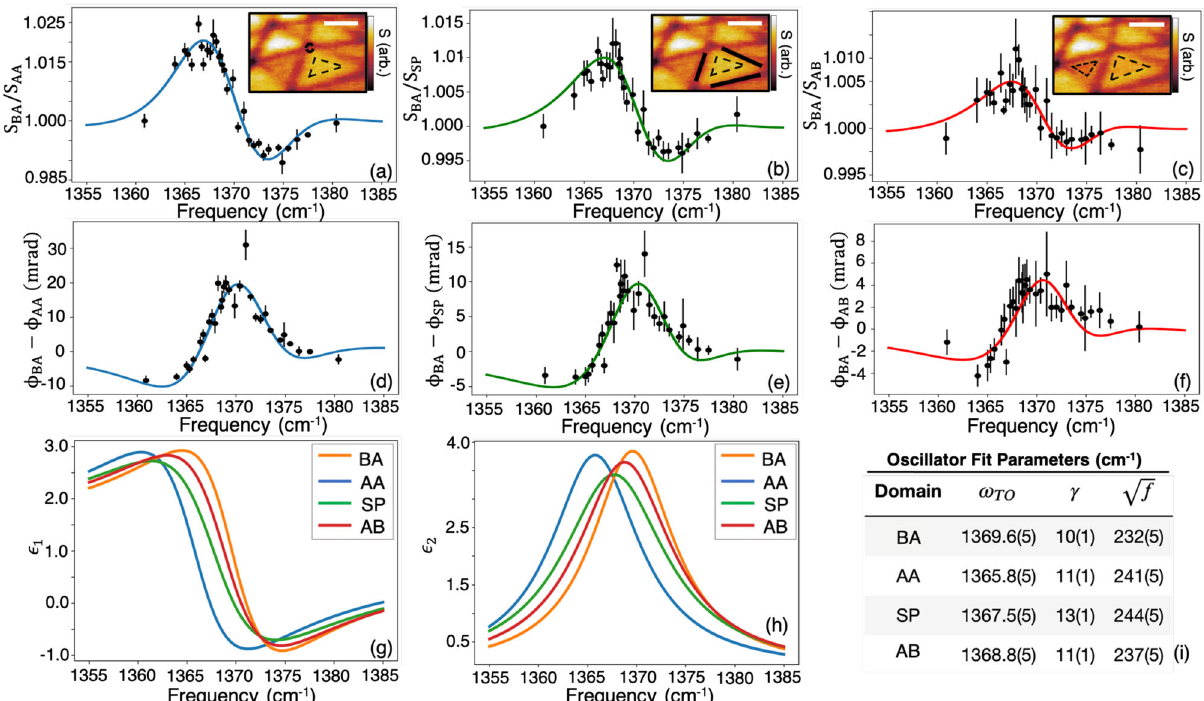
Fig. 2 Stacking-dependent nano-IR spectroscopy of t-hBN. a – c Spectra of the scattering amplitude ratios for three independent con fi gurations averaged over AB, BA, and SP regions. The insets are near- fi eld amplitude images of sample 1 at 1367.9 cm − 1 marking the regions used to construct spectra in the main panels (scale bars are 200 nm). d – f Spectra of nano-IR phase differences for three independent con fi gurations averaged over AB, BA, and SP regions. The error bars in a – f equal the standard deviation (SD) from averaging amplitude and phase channels across pixels of identical stacking (see “ Methods ” for more details). All spectra are all simultaneously fi t to the Lorentz model (Eq. (1)). The solid lines show the resulting fi tting curves described in the text. g , h Spectra of the extracted dielectric functions. i The fi tting parameters, with uncertainties on the last digit in parentheses (e.g., 1369.6(5) = 1369.6±0.5), are reported in the table on the bottom right (all in units of wavenumbers). The uncertainties are taken to be the fi tting parameters ’ SD upon varying the initial guess